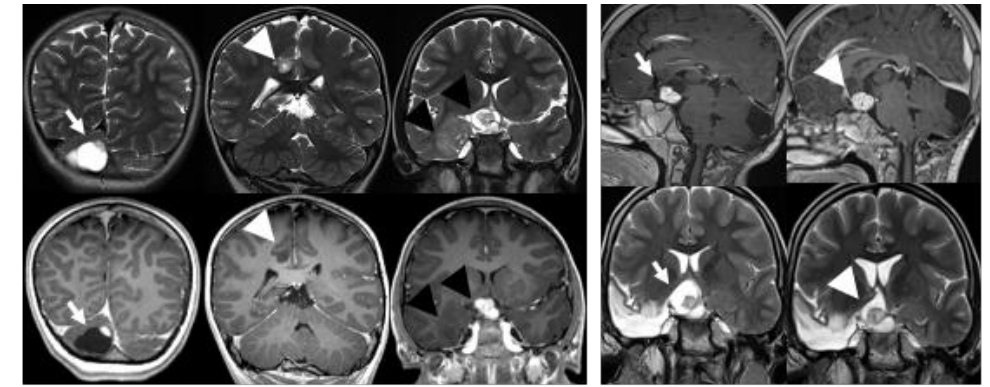
Figure 2. ( A ) Coronal T2w (top row) and T1w (bottom row) images show cystic lesion in the cerebellum with a peripheral enhancing nodule (arrows), a small hyperintense lesion without contrast-enhancement involving the right gyrus cinguli (arrow heads). There is also a suprasellar/chiasmatic lesion (black arrows) with avid contrast-enhancement and cystic components, consistent with optic pathway glioma and a hyperintense and non enhancing lesion involving the right mesial temporal lobe (black arrow heads); ( B ) sagittal GdT1w (top row) and coronal T2w (bottom row) images show optic pathway glioma before (arrows) and during treatment (arrow heads).